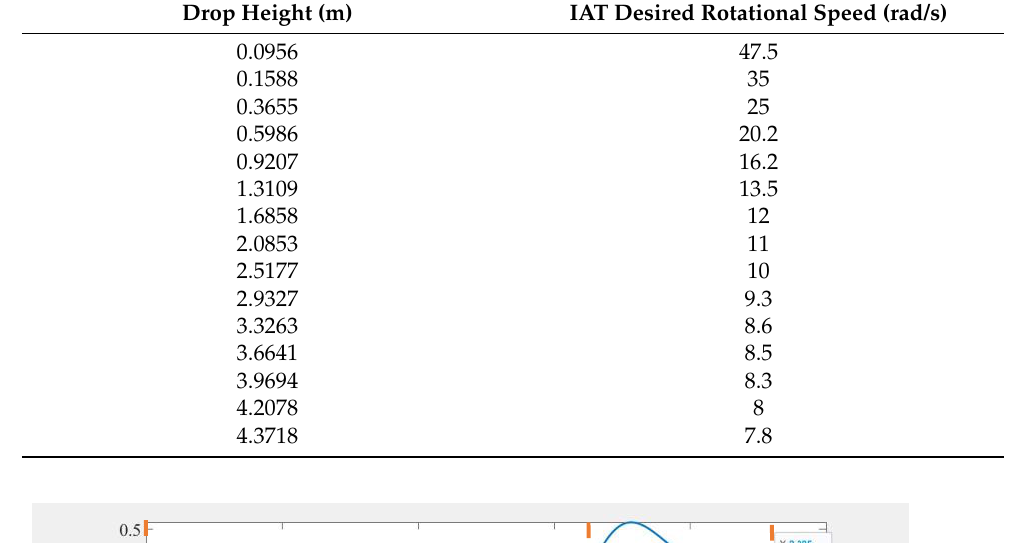
Table 3. Simulated jump height at different launch squat angles.